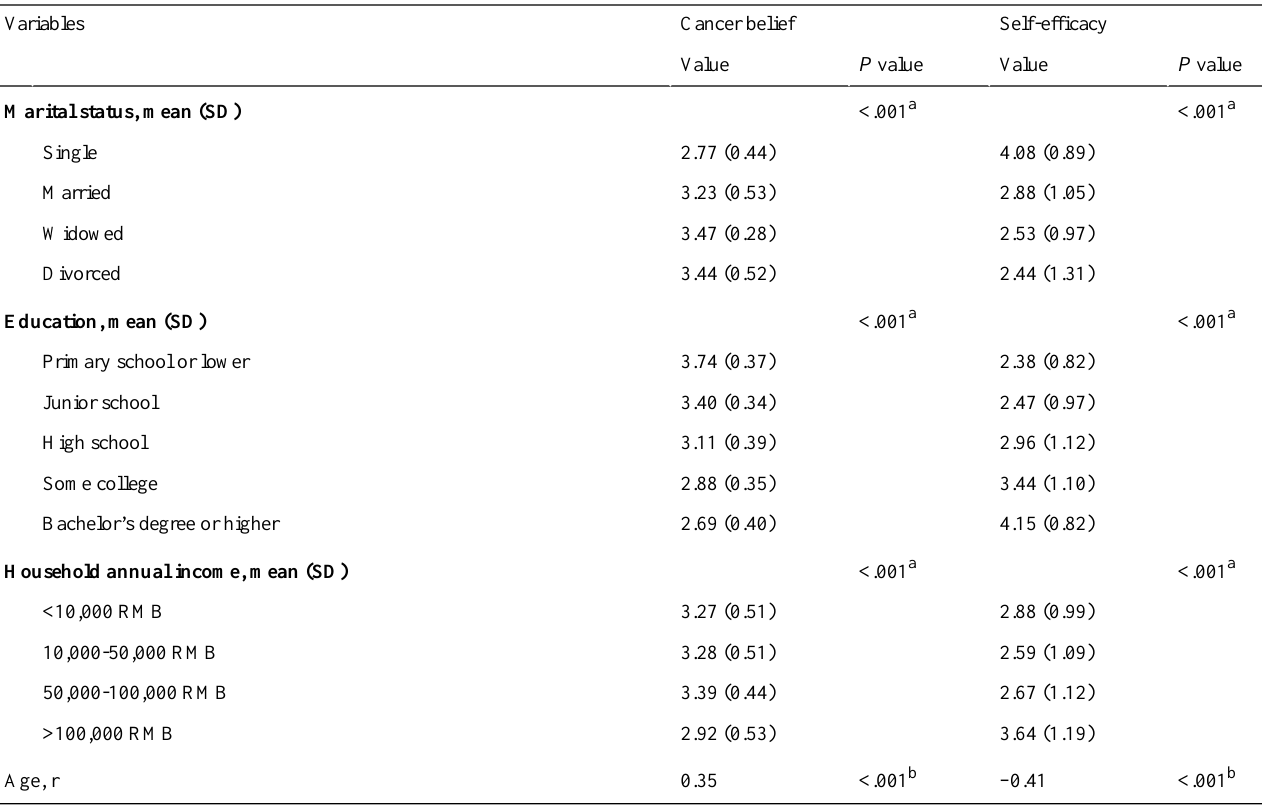
Table 2. Results of bivariate